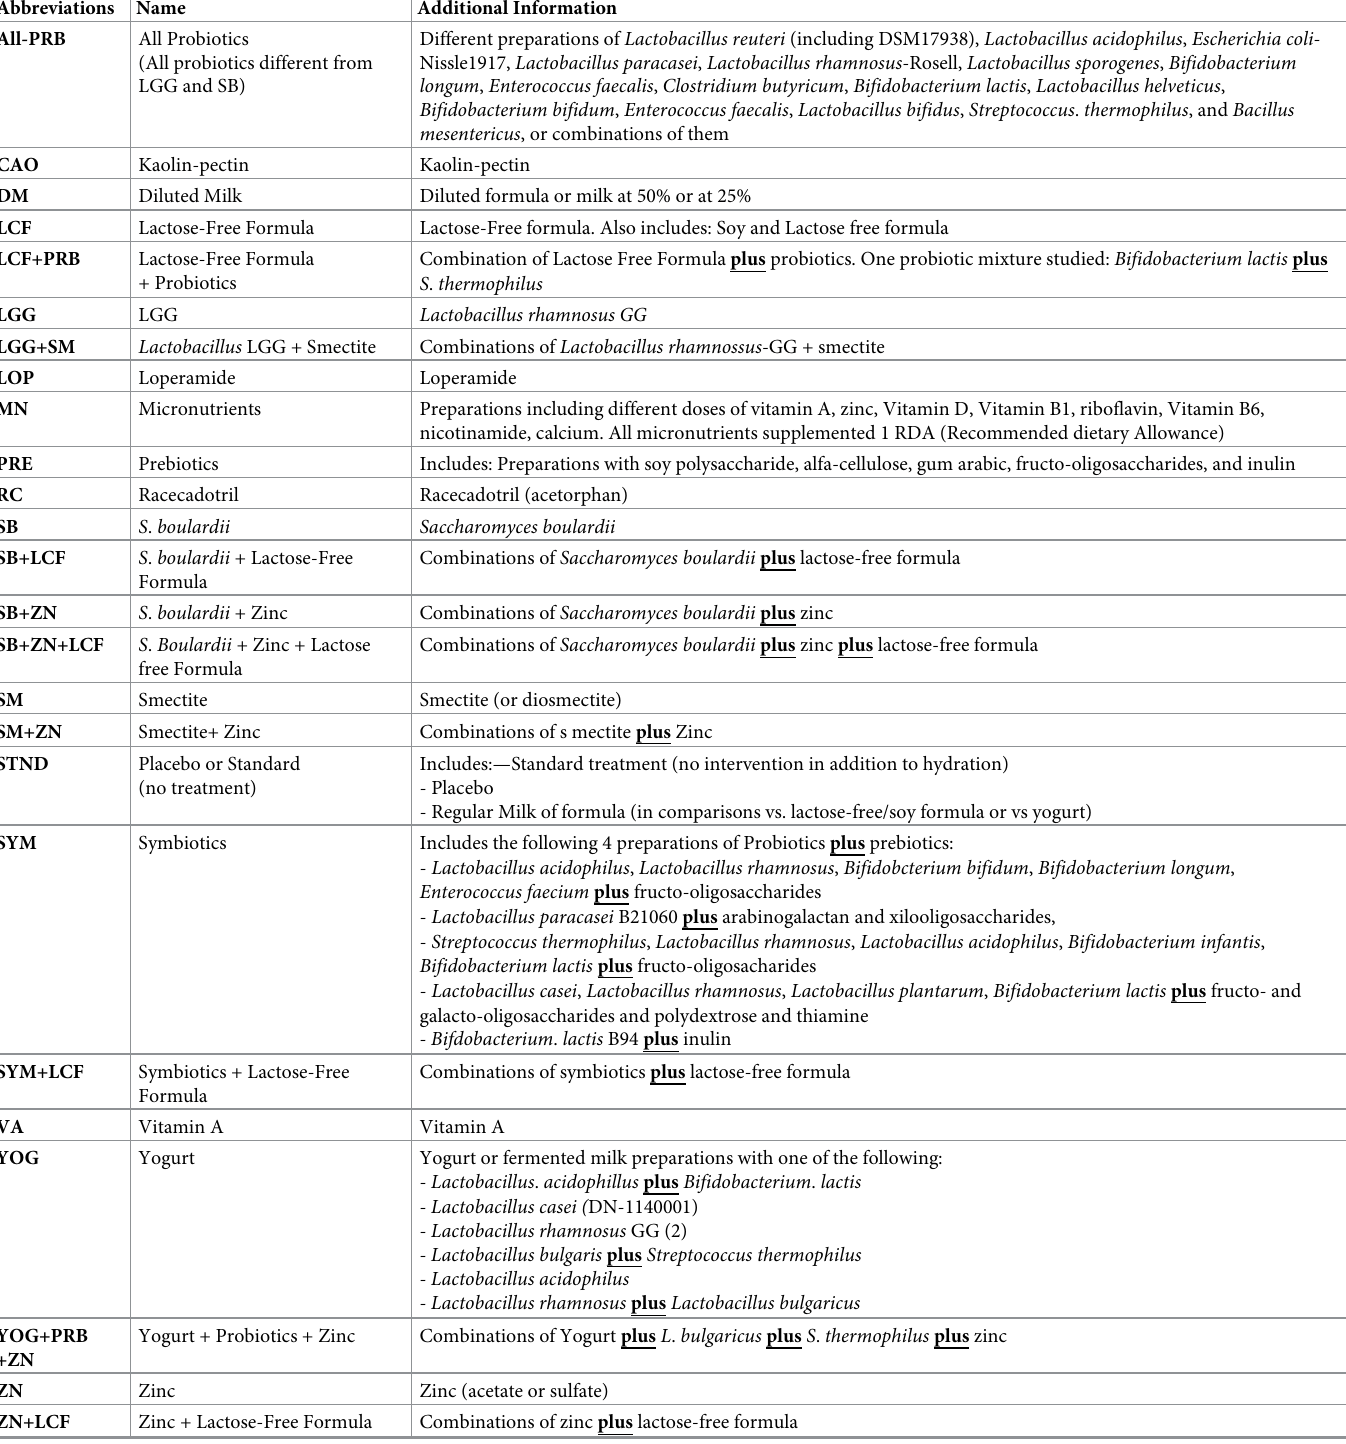
Table 1. Classification of